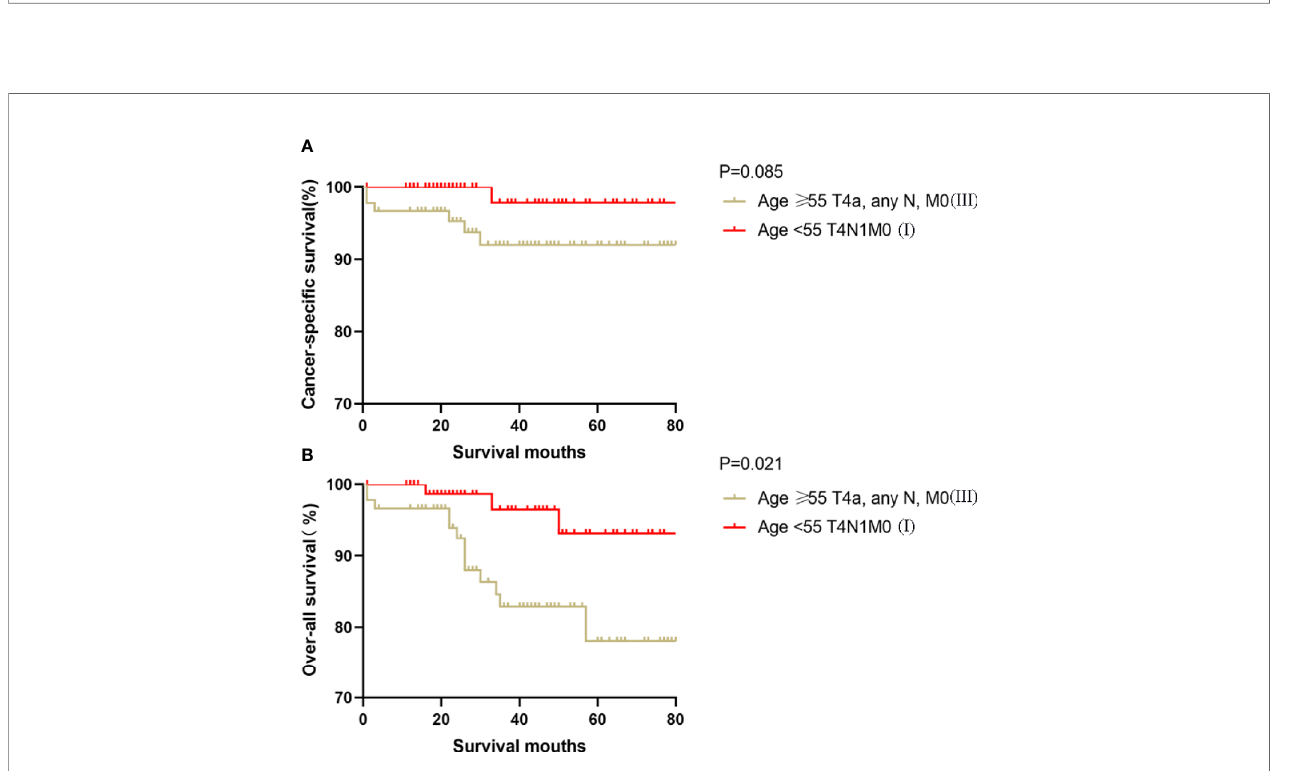
FIGURE 6 | Kaplan – Meier curves for cancer-speci fi c survival (A) and overall survival (B) between FVPTC patients aged ≥ 55 years with stage T4a, any N, M0 disease and patients aged <55 years with stage T4N1M0 disease.